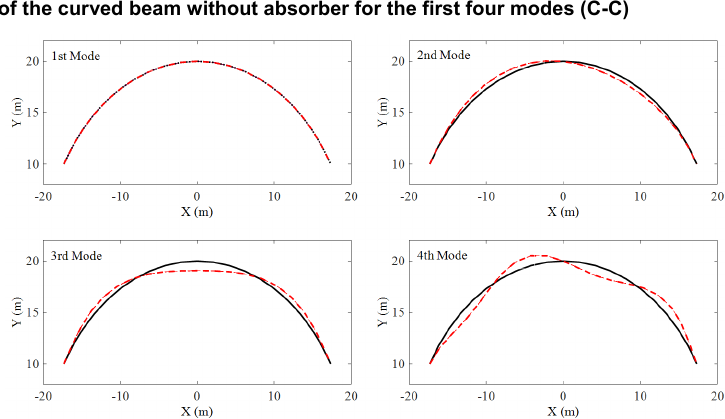
Figure 5. The mode shape of the curved beam with absorber for the first four modes (C-C)